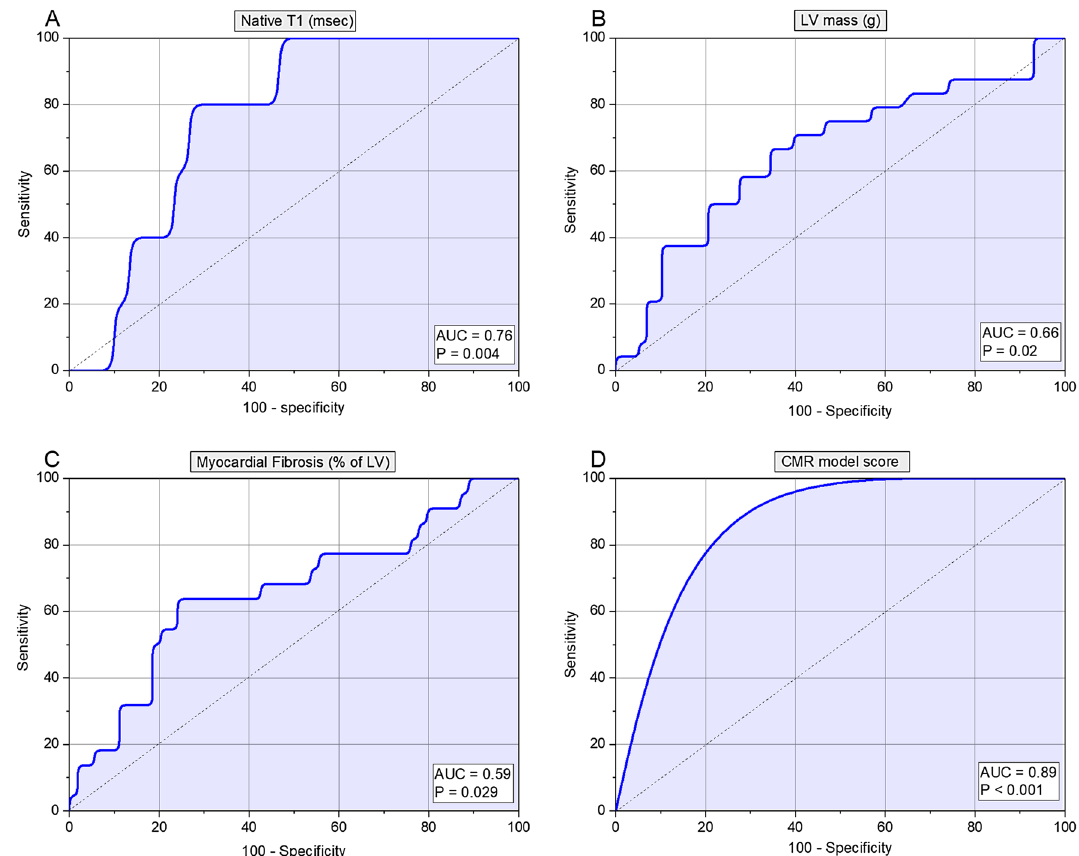
Figure 2. Receiver operator characteristics (ROC) results for CMR functional parameters.